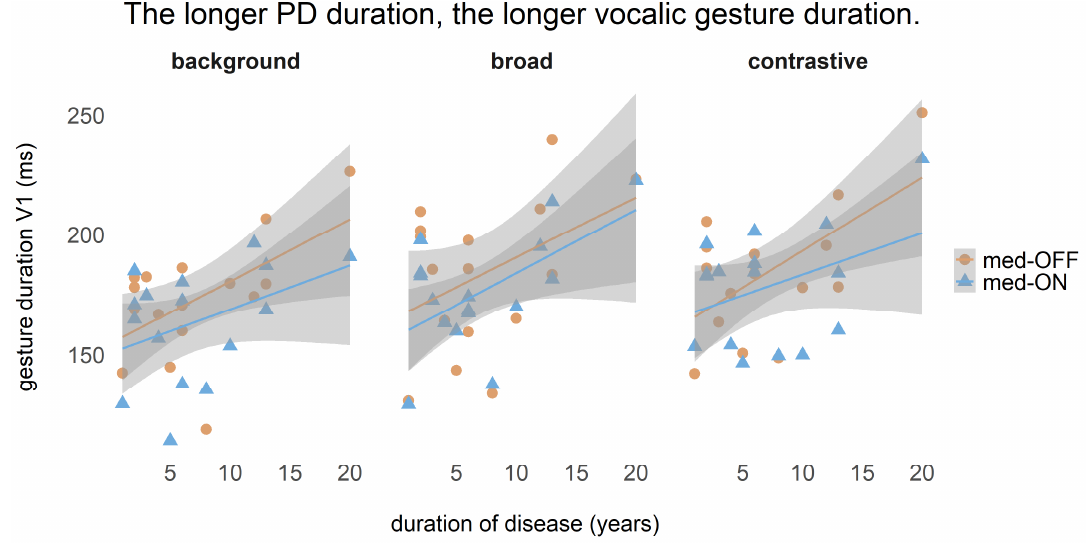
Figure 9. Correlation between vocalic gesture duration and disease duration per focus structure in med-OFF and med-ON conditions.